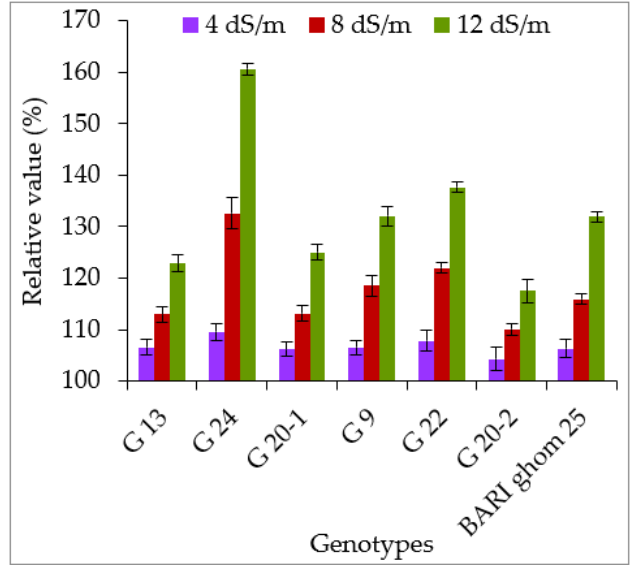
Figure 18. Relative value of hydrogen peroxide (H 2 O 2 ) accumulation in leaf of wheat genotypes under various salinity levels. The vertical bar indicates average data of five independent replicates ( n = 5). Error bars represent standard error.